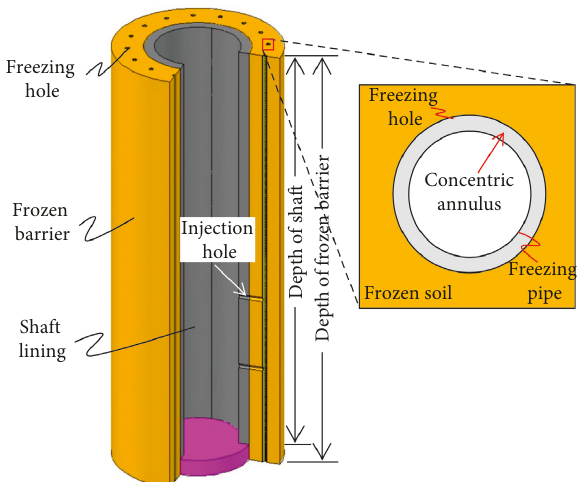
Figure 1: Schematic diagram of full-depth artificial freezing technology in construction of a deep mine